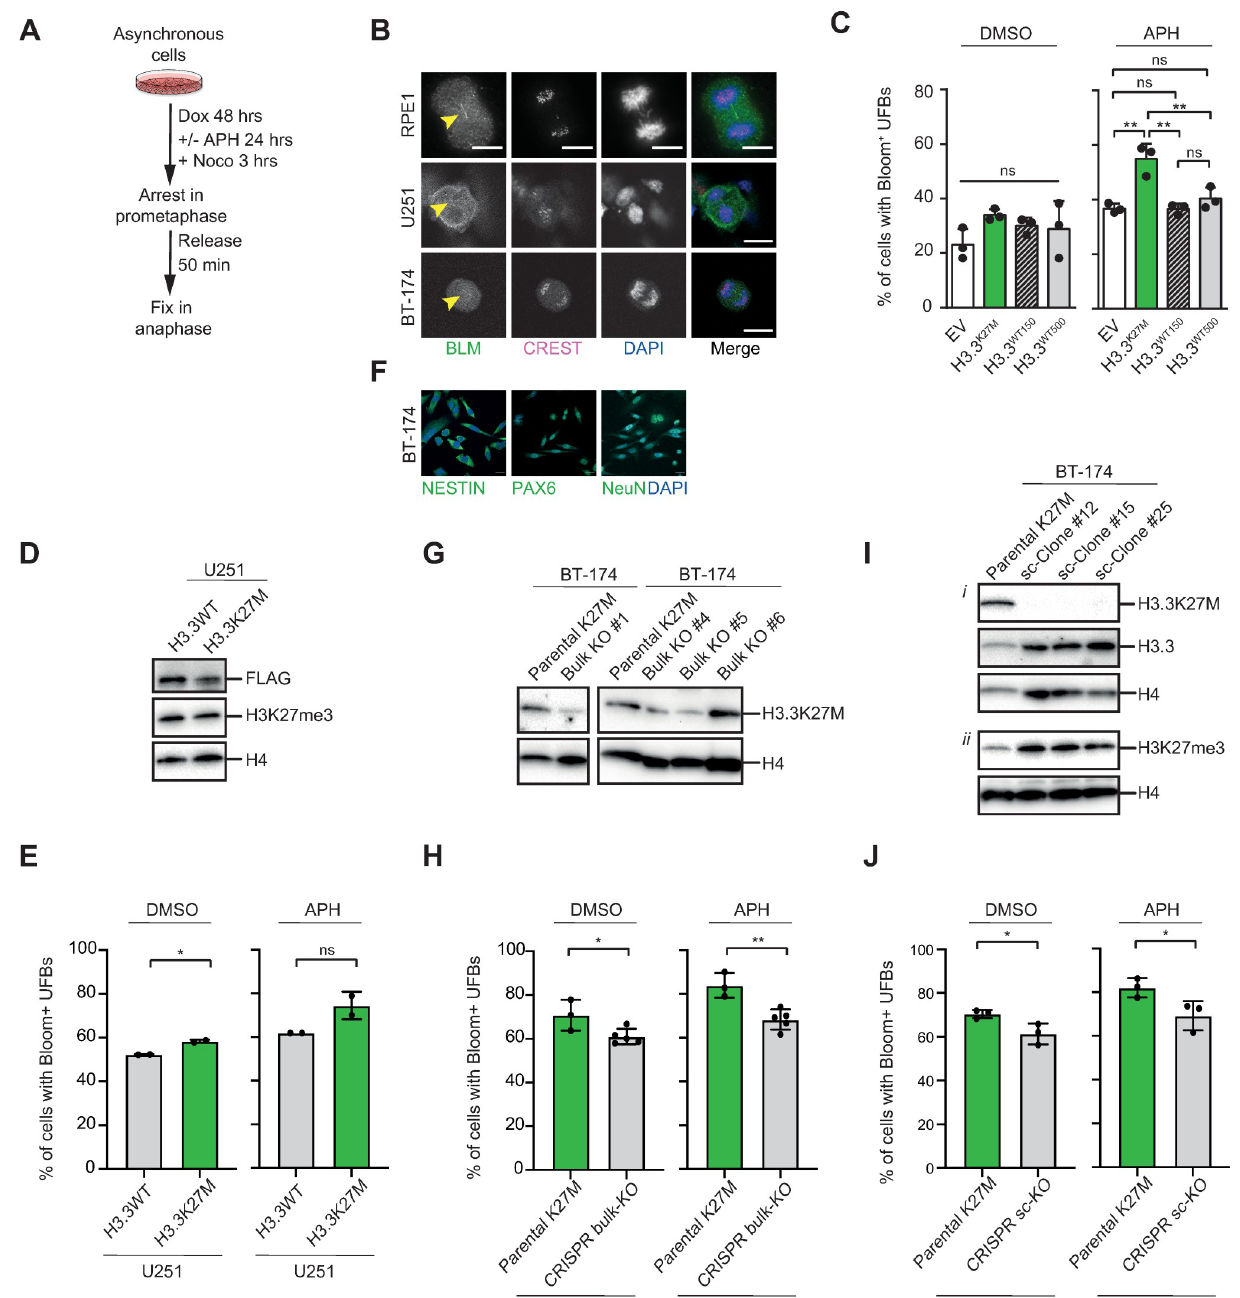
Fig 4. H3.3K27M affects replication stress-induced DNA ultrafine bridge (UFB) formation. (A) Experimental outline for determining the number of replication stress-induced DNA ultrafine bridges (UFBs) in RPE1 cells. Doxycycline induced asynchronized cells were treated with Aphidicolin (APH) for 24 hrs and subsequently blocked in mitosis with Nocodazole to enrich for mitotic cells. After release, cells were fixed in anaphase enabling visualisation of DNA UFBs. Note that for U251 and BT-174 UFB experiments, no Doxycycline pre-treatment was performed. (B) Confocal images showing representative examples of Bloom (BLM) coated DNA UFBs (indicated by arrowheads) in RPE1 cells (upper panels), U251 cells (middle panels) and BT-174 cells (lower panels). CREST immunolabeling reveals kinetochores, counterstaining was performed with DAPI. Scale bars represent 10 μ m. (C) Quantification of Bloom coated DNA UFBs upon Aphidicolin (APH) and Nocodazole treatment of RPE1 cells. Data are represented as means ± SD (n = 3 experiments with +/- 30 mitoses per condition), �� P = 0.0013, 0.0012 and 0.0055, (one-way ANOVA, Tukey correction for multiple comparisons). (D) Western blot showing FLAG and H3K27me3 expression in U251 human glioblastoma cells transfected with either H3.3WT or H3.3K27M expression constructs. H4, histone H4, loading control. (E) Quantification of Bloom coated DNA UFBs upon Aphidicolin (APH) and Nocodazole treatment of U251 cells. Data are represented as means ± SD (n = 2 experiments with > 20 mitoses per condition), � P = 0.0377 (paired t-test). (F)